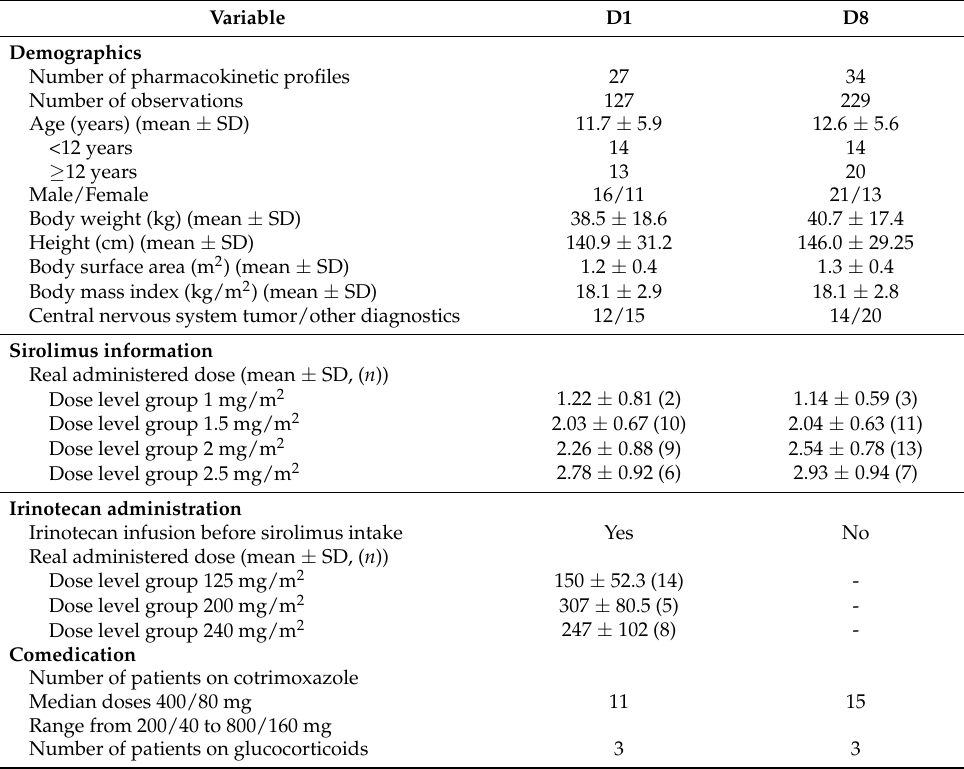
Table 2. Demographic characteristics and main information about sirolimus and